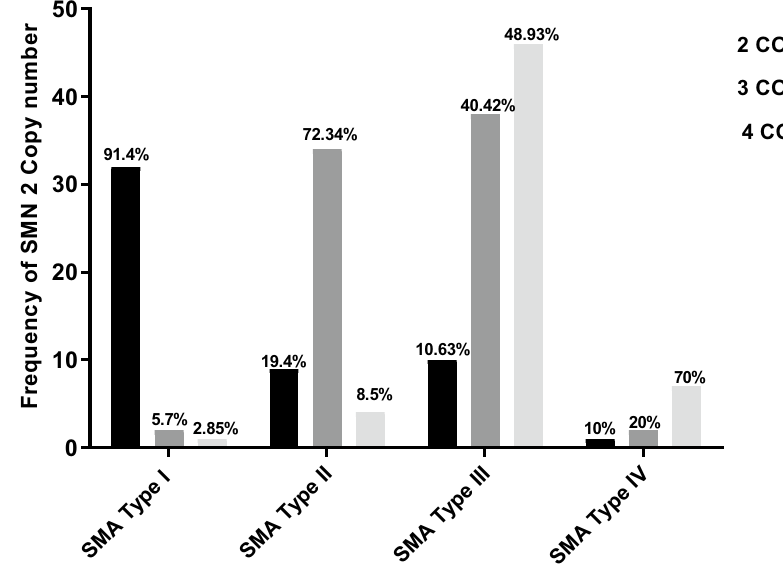
Figure 1. The percentage of individuals with various numbers of exon 7 of the SMN2 gene.